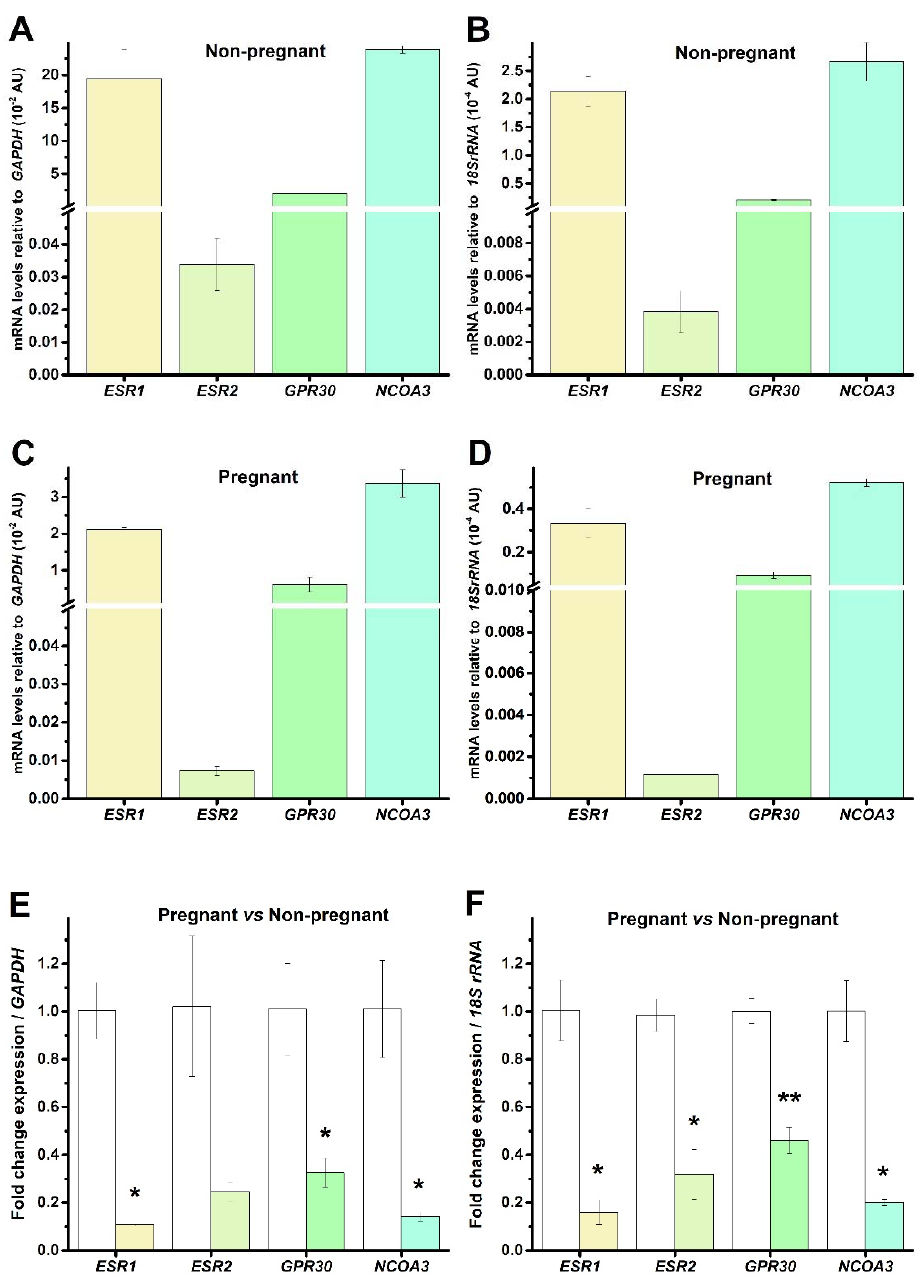
Figure 2. mRNA levels encoding the estrogen receptors and nuclear receptor co-activator in human myometrial TCs from non-pregnant ( A , B ) and pregnant ( C , D ) uterine samples. The mRNA levels of ESR1 (estrogen receptor 1), ESR2 (estrogen receptor 2), GPR30 (G protein-coupled receptor 30), and NCOA3 (nuclear receptor coactivator 3), were normalized against two different reference genes, GAPDH ( A , C ) and 18S rRNA ( B , D ) and were plotted as mean ± SD ( N = 3), corresponding to cell batches extracted from either pregnant or non-pregnant uterine myometrium. ( E , F ) Fold-change for each estrogen receptor in pregnant uterine samples versus the non-pregnant condition, where non-pregnant samples were defined as calibrator, considering as housekeeping gene GAPDH ( E ) and 18S rRNA ( F ), respectively. Statistical significance is indicated with asterisks (* 0.01 < p < 0.05; ** 0.001 < p < 0.01).